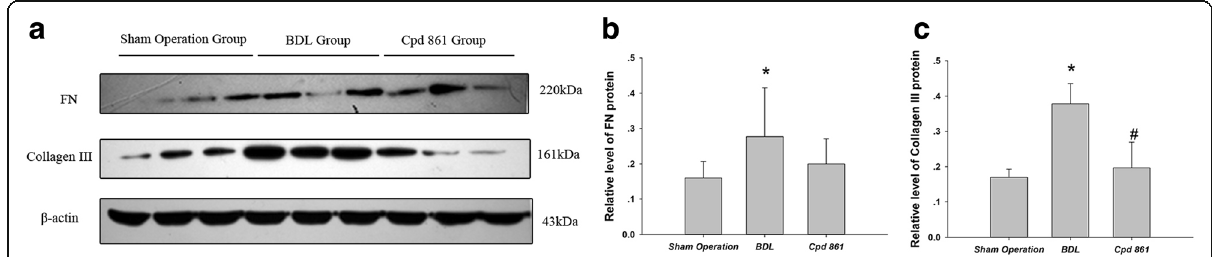
Fig. 2 a Collagen III, fibronectin, and β -actin expression levels, as determined by Western blot, with β -actin used as a loading control. Quantification of Western blot results for relative levels of ( b ) fibronectin and ( c ) collagen III. Data are expressed as means ± standard deviations ( n = 6). One-way analysis of variance was used for statistical comparisons. * P < 0.05 vs sham operation group; # P < 0.05 vs BDL